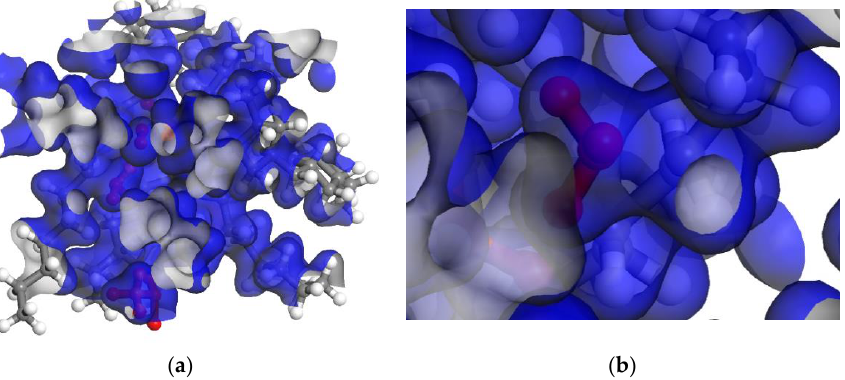
Figure 9. ( a ) Iso-surfaces of electron density are indicated with blue, and the carboned-fragments are indicated with red; ( b ) partial enlarged detail near CH 3 .